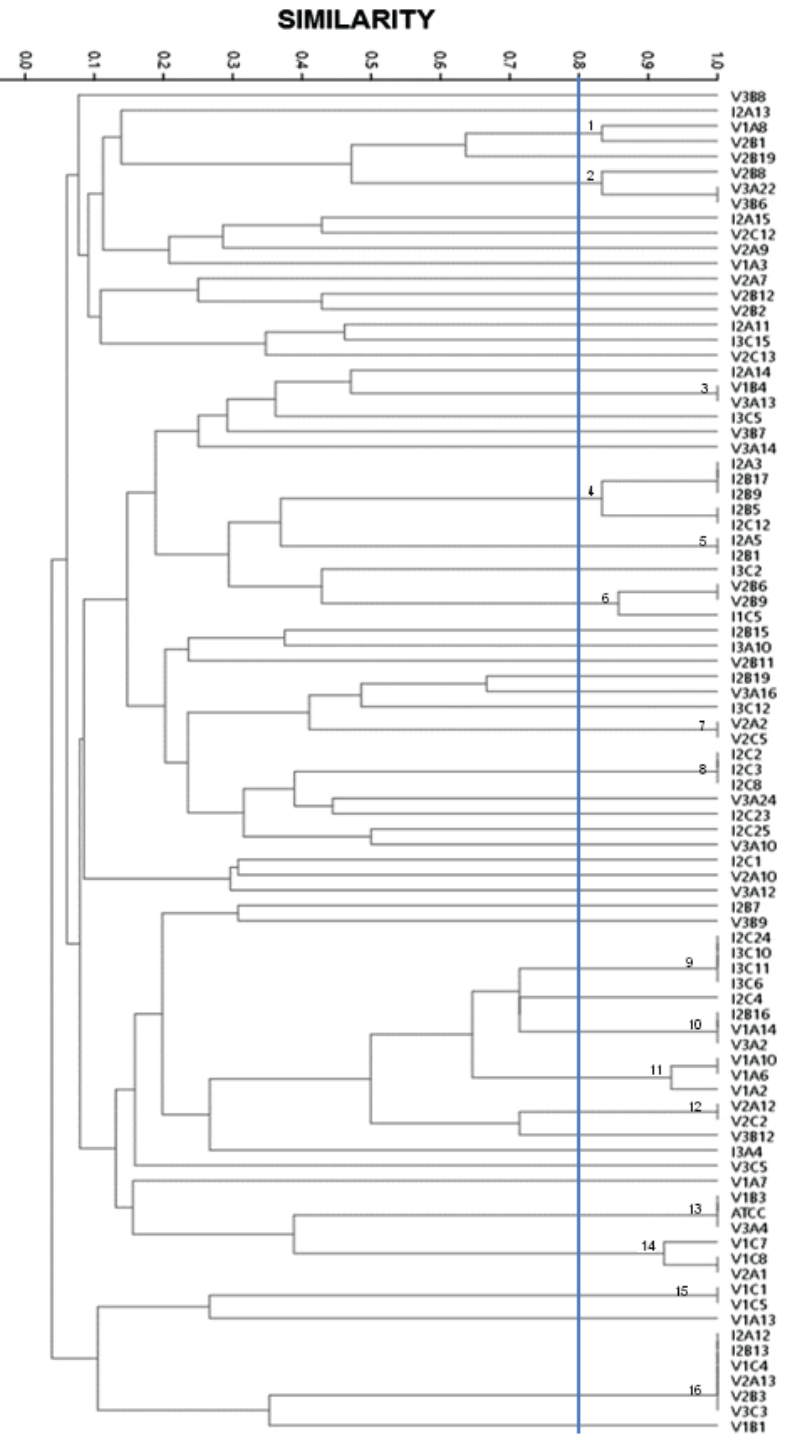
Figure 1 - Dendrogram of samples submitted to PCR-RFlP using the enzymes Hinf I, Hae III and Cfo I. The similarity matrix was calculated using the Paleontological Data Analysis (PAST) software using the Dice coefficient by the unweighted pair group method using arithmetic averages